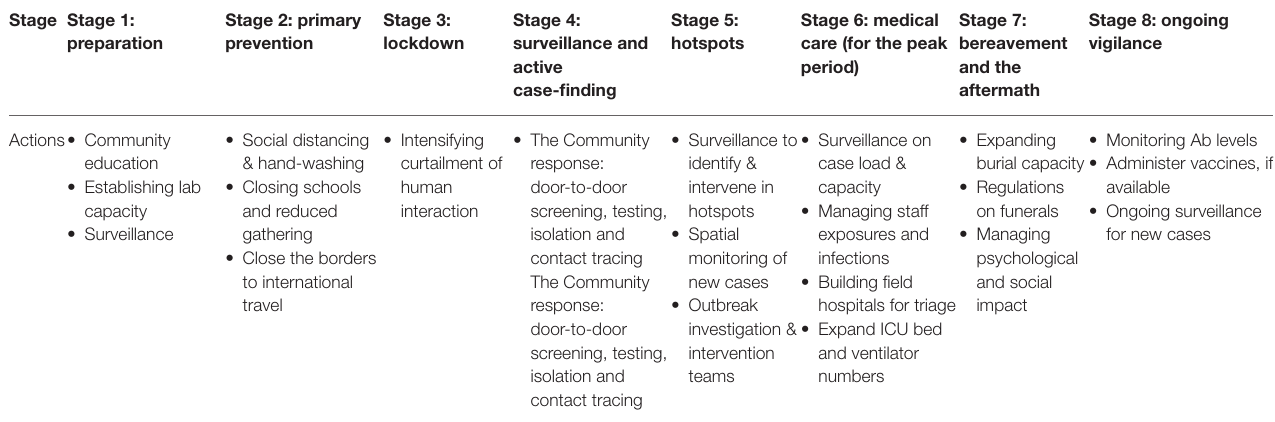
TABLE 2 | Eight-stage process to manage the COVID-19 pandemic [adapted from SA Coronavirus (n.d.)]. Stage Stage 1: